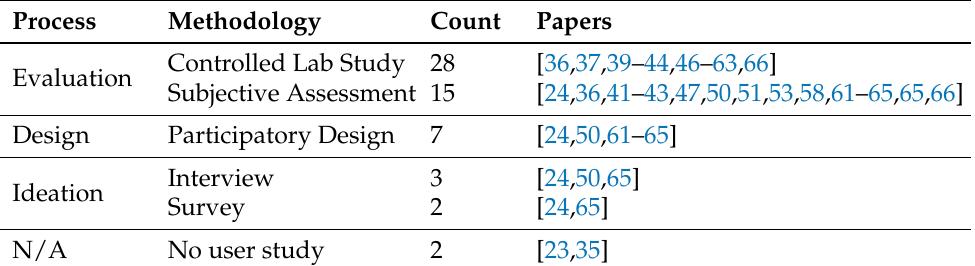
Table 6. Methodologies used in the studies and BLV’s involvement in system design and eval- uation. Note that the following three studies conducted user studies with blind-folded sighted participants